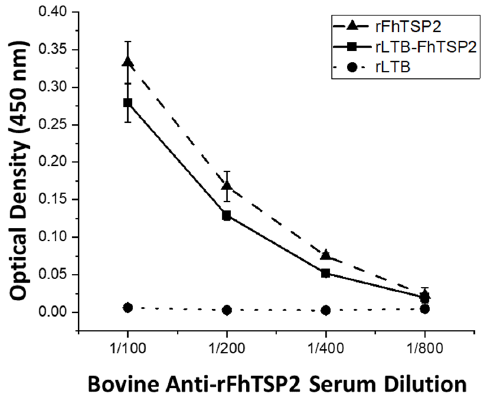
Figure 4. Characterisation of the antigenicity of the rLTB ‐ FhTSP2 fusion complex. The reactivity of rFhTSP2, rLTB ‐ FhTSP2, and rLTB was analysed using diluted bovine anti ‐ rFhTSP2 sera (1:100, 1:200, 1:400, and 1:800) and a anti ‐ bovine IgG HRP secondary antibody. Antigens were coated at an equal molar ratio of the FhTSP2 protein sequence.